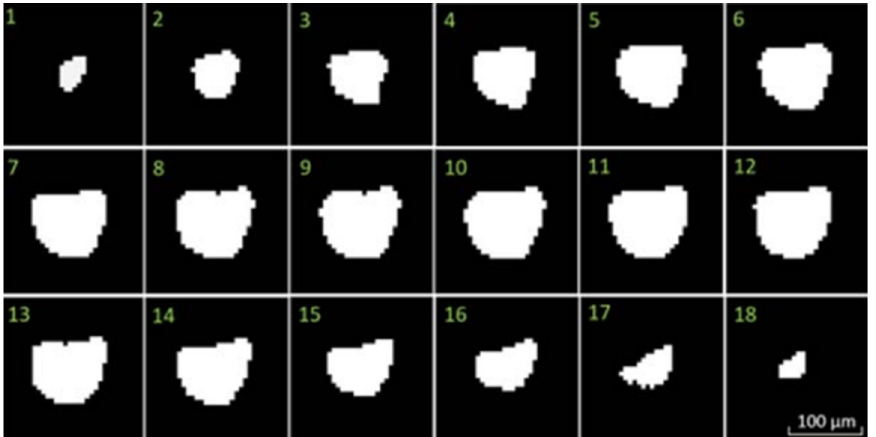
Figure 8. 2D images of different keyhole pores morphologies [6].